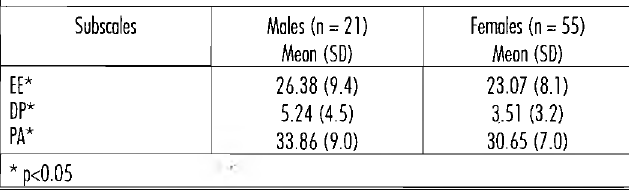
Table III: MBI subscale scores for male and female students Subscales